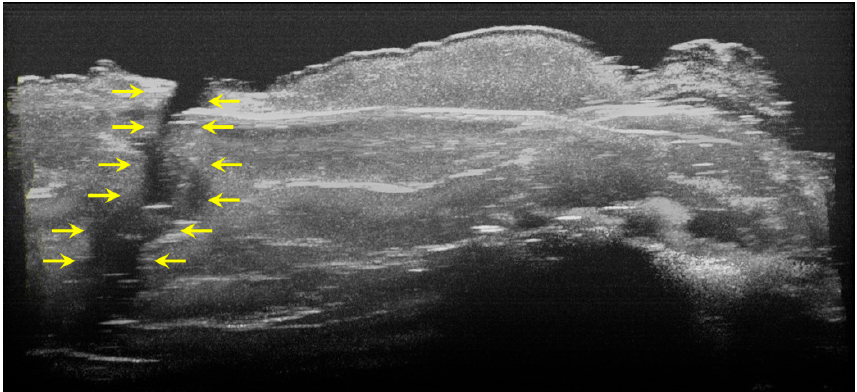
Figure 8. Three-dimensional OCT reconstruction (in ImageJ) of a hypoplasia lesion (Axis 0Y). The yellow arrows indicate a continuous area characterized by the absence of signal, similar to the ap- pearance of a dental crack or fracture.